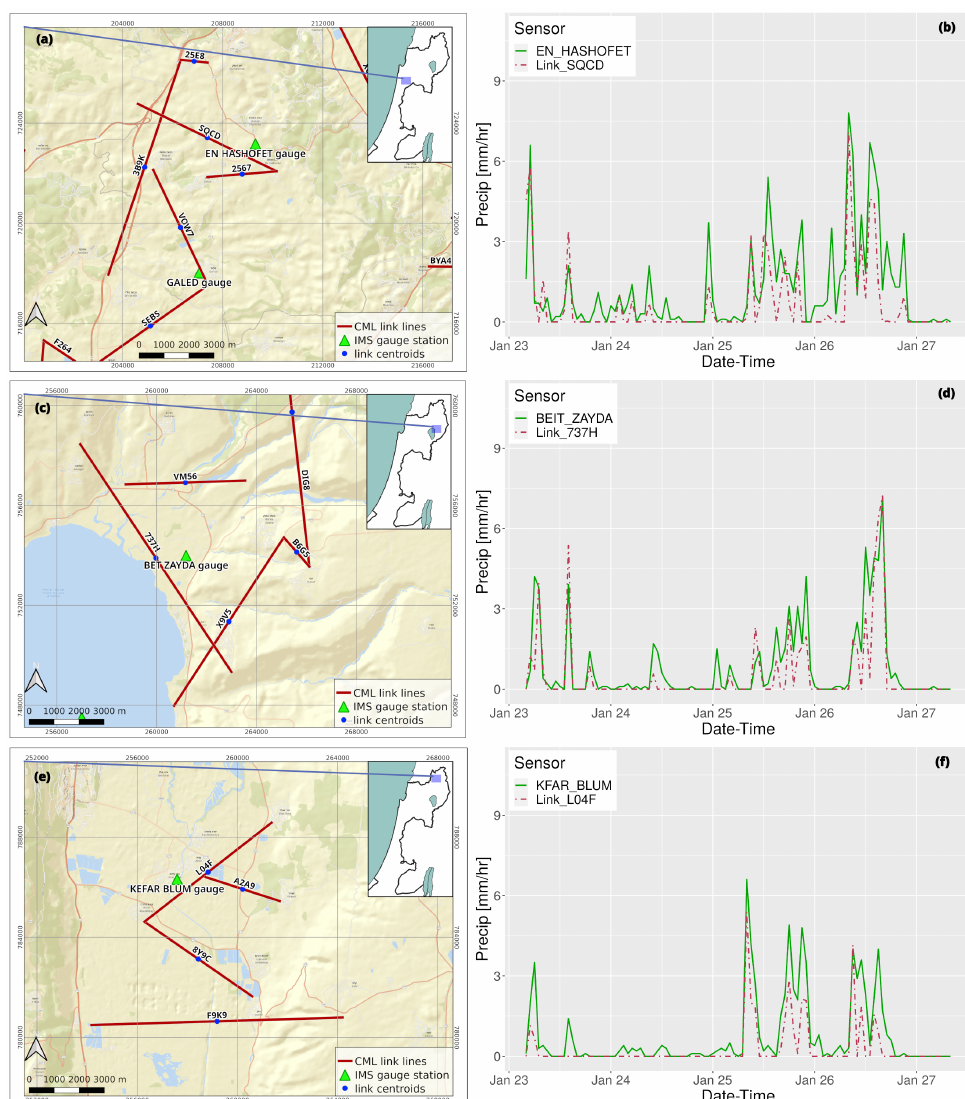
Figure 6. Comparison of hourly rainfall from three CML links and three nearby IMS gauges in northern Israel. Maps ( a , c , e ) show the locations of three particular IMS gauge stations, which are close to CML links. The graphs in ( b , d , f ) present hourly rainfall, where the solid green lines are the true gauge observations, and the red dashed lines represent CML-derived rain rates, both aggregated to millimeters per hour. These CML rain rates were derived using Aa of 1.4